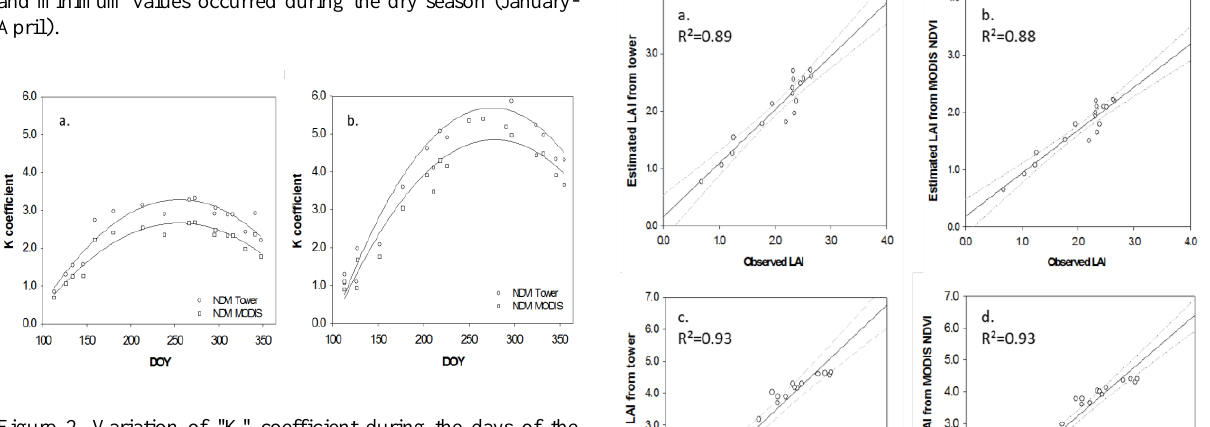
Figure 2. Variation of "K" coefficient during the days of the year (DOY). Early successional plots (a.) and intermediate successional plots (b.) for Santa Rosa National Park, Guanacaste.